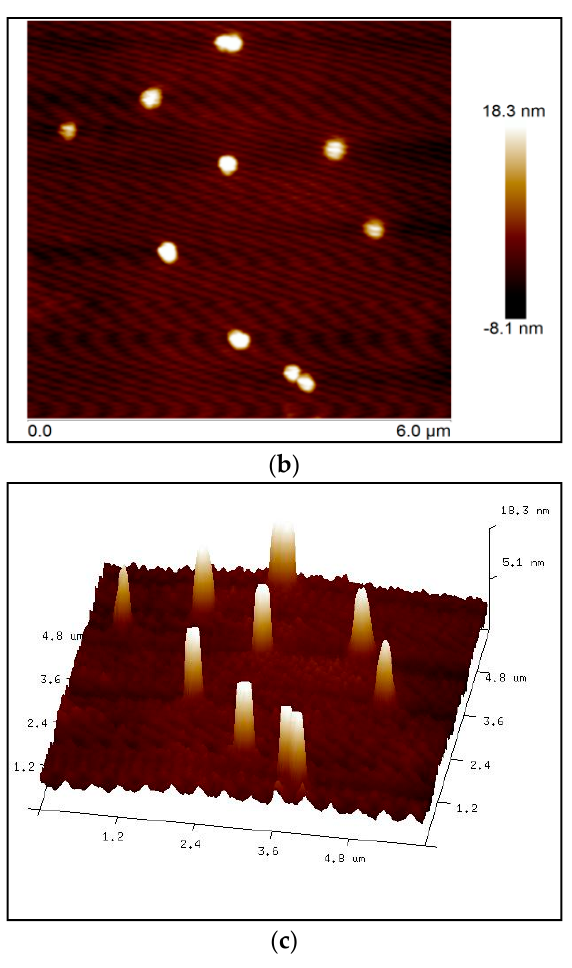
Figure 4. ( a ) Morphological analysis obtained with scanning electron microscopy (SEM) images of CHX-encapsulated nanoparticles. Note that clumping prevented measurement of individual nanoparticle size. Atomic force microscopy (AFM) ( b ) 2D surface topography of nanoparticles and ( c ) 3D image.